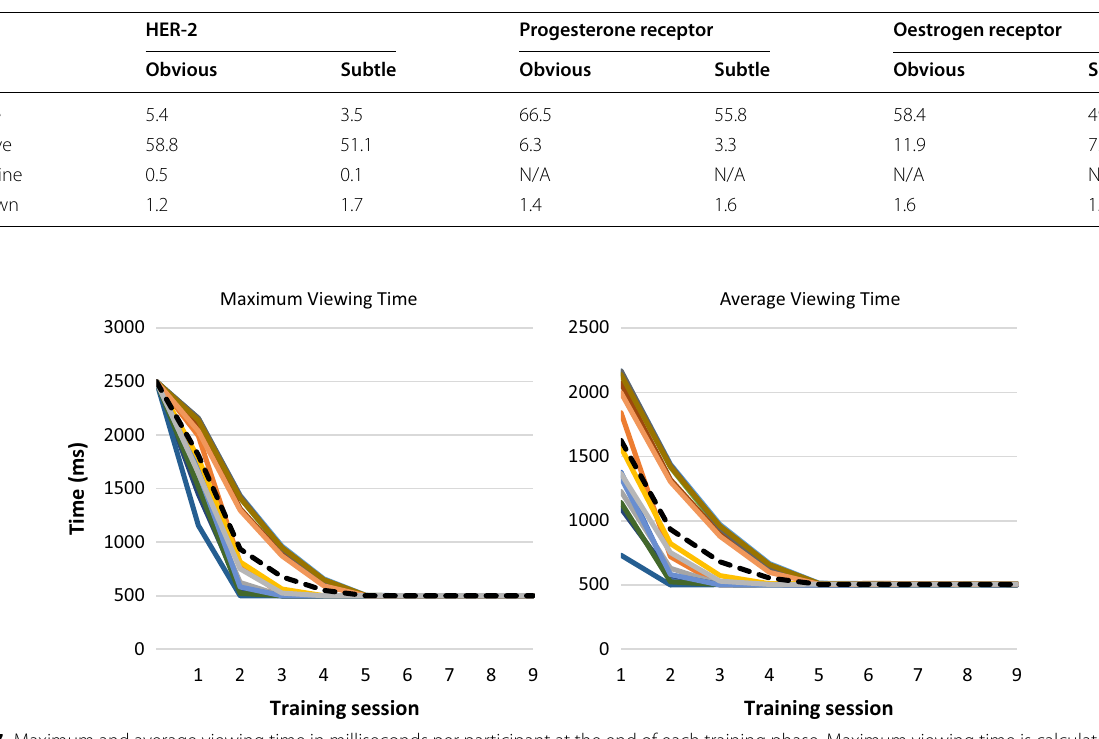
Table 4 Percentage of mammograms that were positive, negative, borderline, or unassessed DCIS grade for the obvious and subtle subsets of the image set. Where descriptors were not available in the OPTIMAM database, the mammogram was classified as unassessed